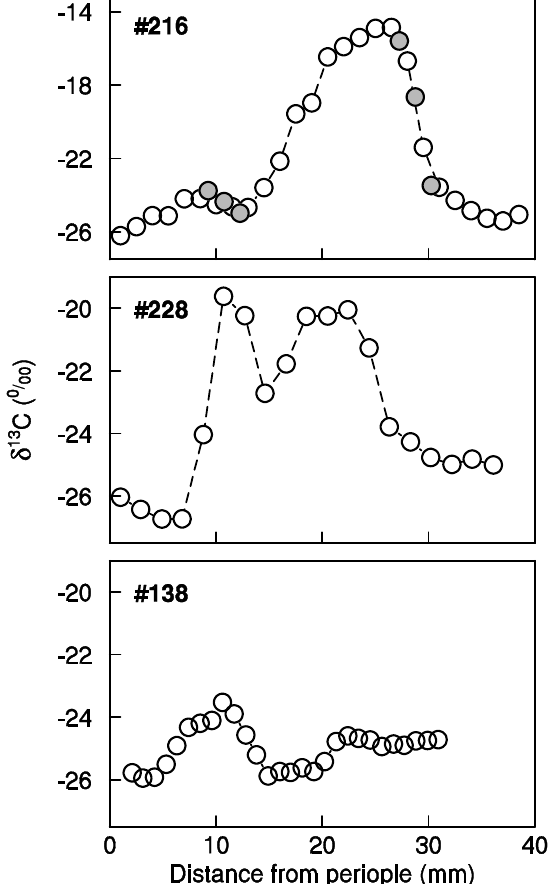
Figure 2. Longitudinal variation of δ 13 C along the anterior edge of the hoof sampled from animal #216, #228, and #138. Note that y scaling differs for #216. Grey filled circles show data from a second sampling. The δ 13 C value of the half-life point on the hoof was determined as: